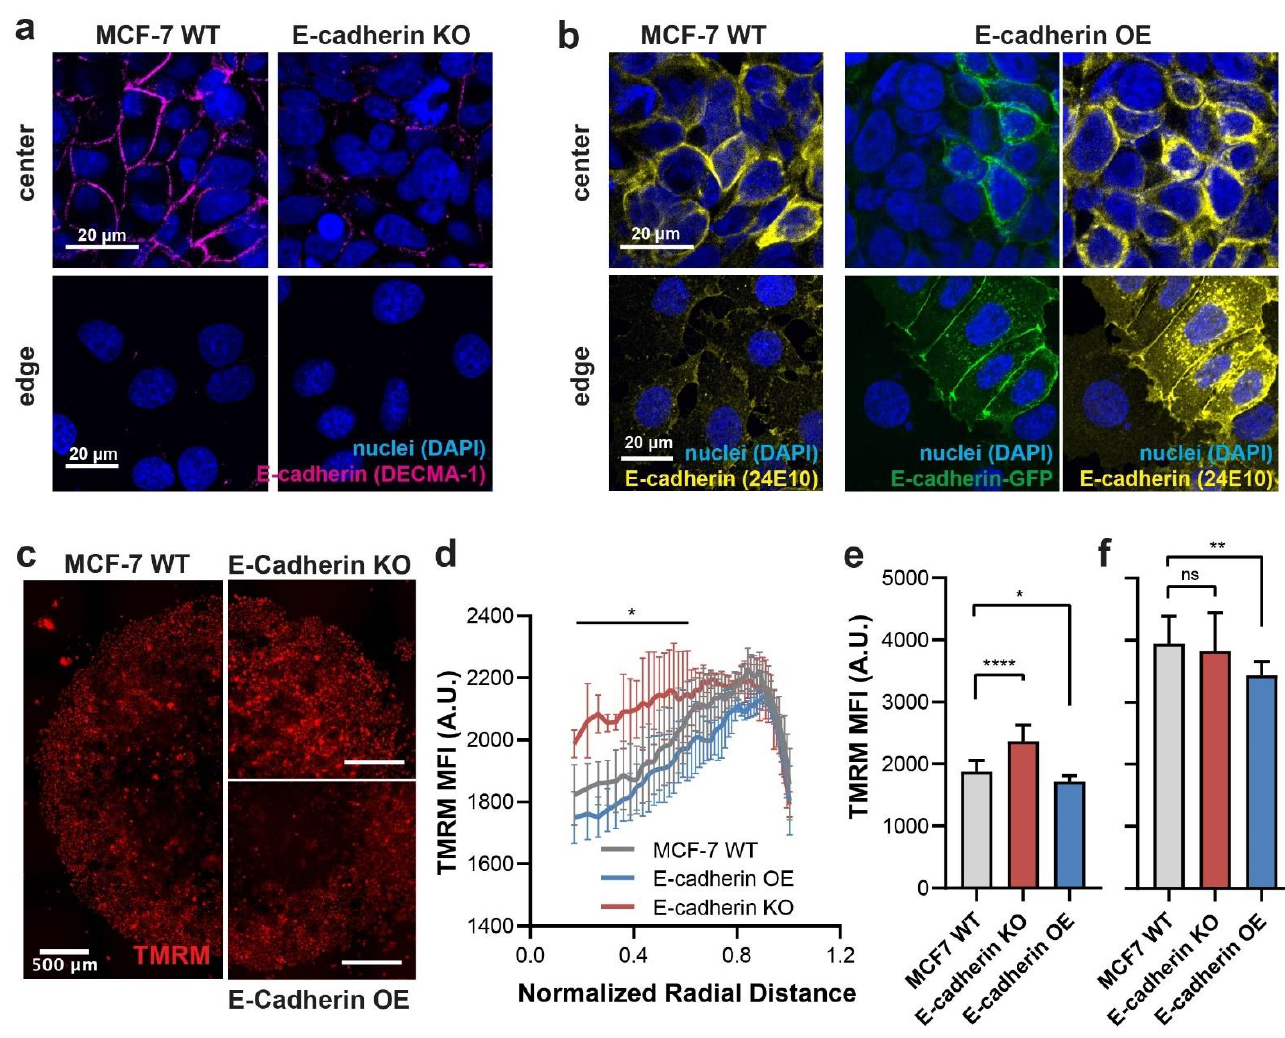
Figure 5. Effects of E-cadherin knockout (KO) and overexpression (OE) on ∆Ψ m in MCF-7 micropatterns. ( a ) Confocal imaging showing the localization and level of extracellular E-cadherin (immunostained by DECMA-1) at the centers and edges of unconfined micropatterns formed by WT and E-cadherin KO MCF-7 cells on day 4. ( b ) Confocal imaging showing the localization and level of E-cadherin by GFP signal and immunostaining (24E10) at the centers and edges of micropatterns formed by WT and E-cadherin OE MCF-7 cells on day 4. ( c ) Spatial distribution of ∆Ψ m indicated by TMRM fluorescence in unconfined micropatterns of WT, E-cadherin KO, and E-cadherin OE MCF-7 cells on day 4. ( d ) Radial distribution of ∆Ψ m in micropatterns shown in ( c ). Data points under the solid line are statistically higher in E-cadherin KO cells compared to WT cells at each radius ( p < 0.05 by 2-way ANOVA). Quantification of average TMRM fluorescence at the centers ( e ) and edges ( f ) of micropatterns shown in ( c ). * p < 0.05, ** p < 0.01, and **** p < 0.0001 in an ordinary one-way ANOVA; n = 3 micropatterns per condition.